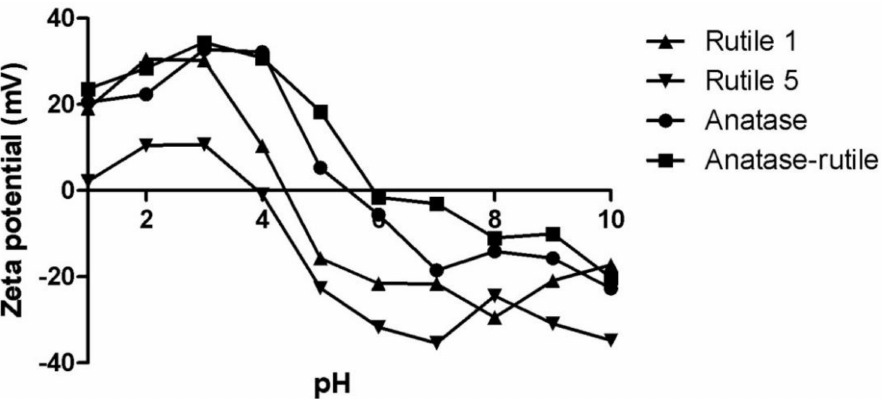
Figure 2. Development of zeta potential of TiO 2 particles with the